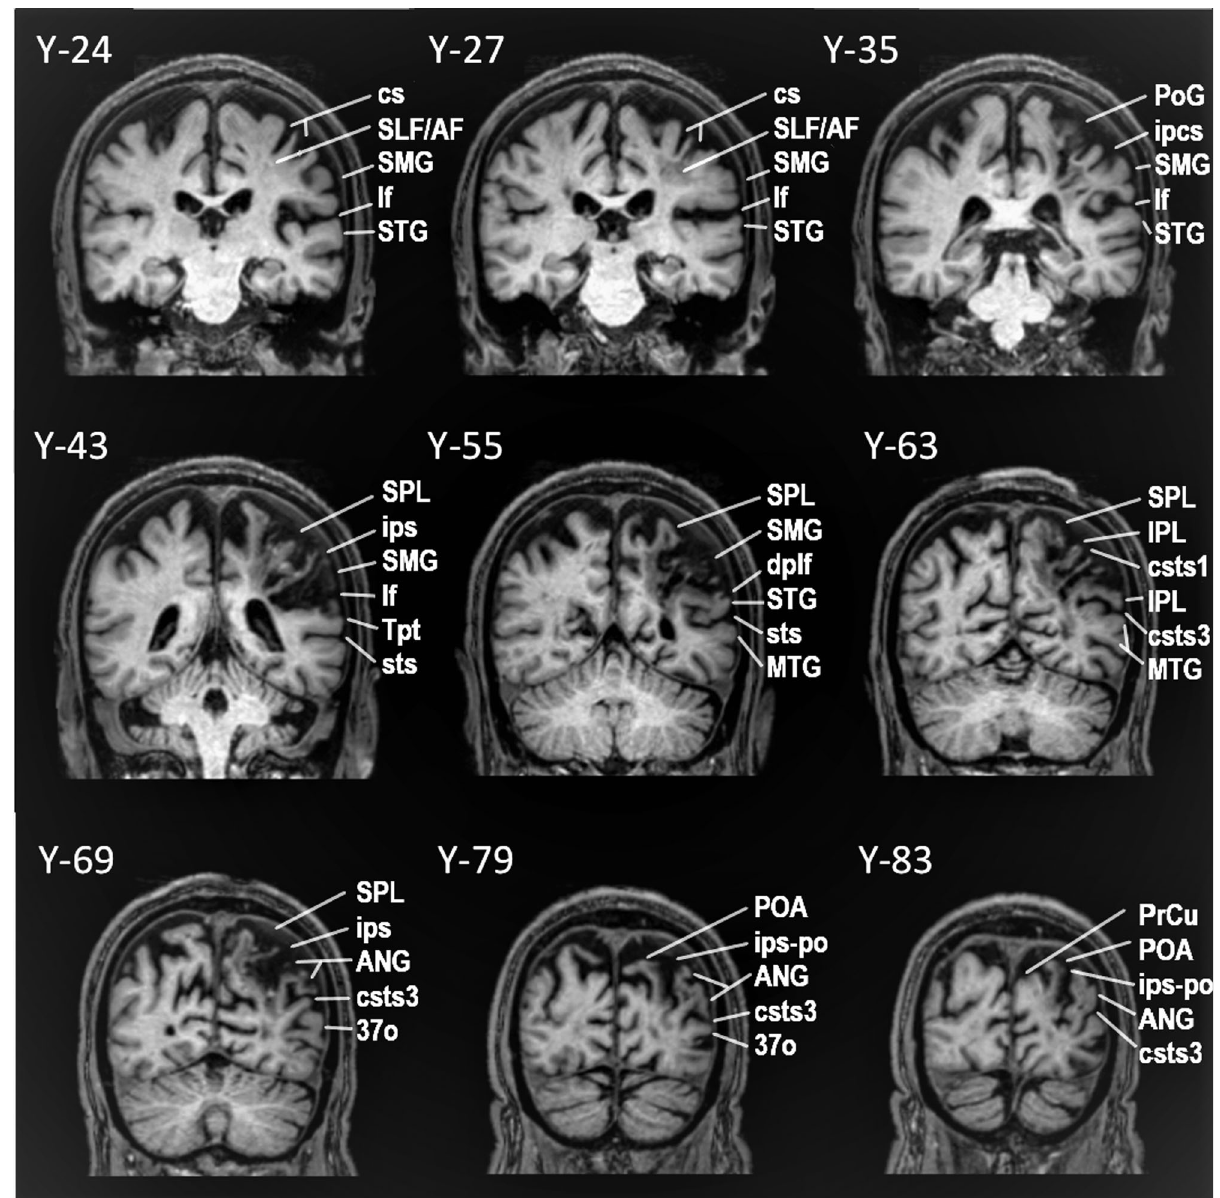
Fig. 5 Successive coronal MRI images in MNI stereotaxic coordinates (Y) depicting the lesion of patient TA with damage to the dorsal posterior language region. The lesion starts posterior to the central sulcus (cs) and after Y-24. At Y-27, the white matter below SMG and postcentral gyrus areas 2, 1, 3b is damaged affecting SLF III fi bers (originating from the SMG), SLF II fi bers (originating from ANG), and AF fi bers (originating from Tpt. At Y 31, a small area of anterior SMG is added to the white matter lesion. At Y-35 and Y-39, the lesion includes SMG and the white matter below. At Y-43, the whole SMG, the white matter below and a small part of area Tpt, that is the caudal STG, is damaged, leaving primary acoustic areas on Heschl ’ s gyrus intact. Further posteriorly, at Y-47, -51, -55 as well as -59, damage continues to include the whole SMG and SPL (Superior Parietal Lobe), occupying a larger part of STG (see Y-55). At Y-63, superior and inferior parietal lobule areas, including areas PFm and PG, as well as the white matter below, until csts3 are affected. At Y-67 till Y-71, the superior and inferior parietal lobule areas, including ANG, as well as the underlying white matter until the area just below csts2, are lesioned (see Y-69). At Y-75, Y-79, and Y-83, the precuneus, superior and inferior parietal lobule areas until csts3 are affected, while at Y-83, the lesion includes the areas of POA and the whole ANG until csts3. The lesion continues further posteriorly to parieto-occipital areas, affecting even occipital areas such as area 19, in Y-98, where the lesion ends. Brain areas are topologically de fi ned according to the atlas of the morphology of the human cerebral cortex in the MNI Stereotaxic Space 67 . 3a: area 3a; 37o: lateral occipitoparietal area 37; AF Arcuate Fasciculus; ANG angular gyrus; cs central sulcus; csts1, csts3 caudal superior temporal sulcus, 1st and 3rd ramus; IPL inferior parietal lobule; ipcs inferior postcentral sulcus; ips intraparietal sulcus; ips-po intraparietal sulcus, paroccipital part; lf lateral fi ssure; MTG middle temporal gyrus; POA parieto-occipital arcus; PoG postcentral gyrus; PrCu precuneus; SLFII/III superior longitudinal fasciculus, subdivision II/III; SMG supramarginal gyrus; SPL superior parietal lobule; STG superior temporal gyrus; sts superior temporal sulcus; Tpt caudal superior temporal cortical region.